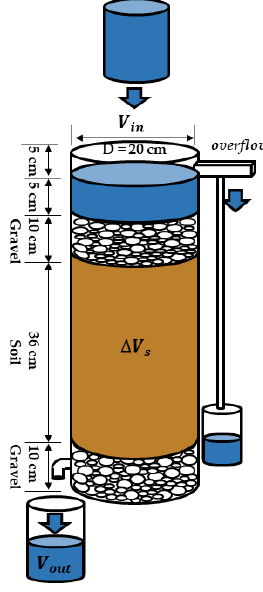
Figure 1. A conceptual diagram of the experiment. Table 1. Water quality analysis results for tap water.